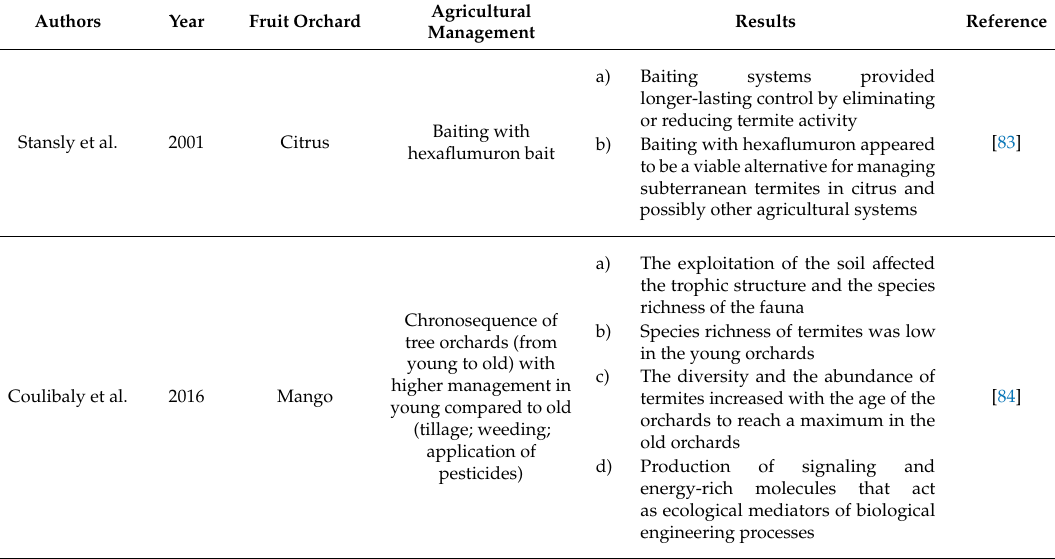
Table 3. E ff ects of di ff erential agricultural management on termite dynamics in orchard